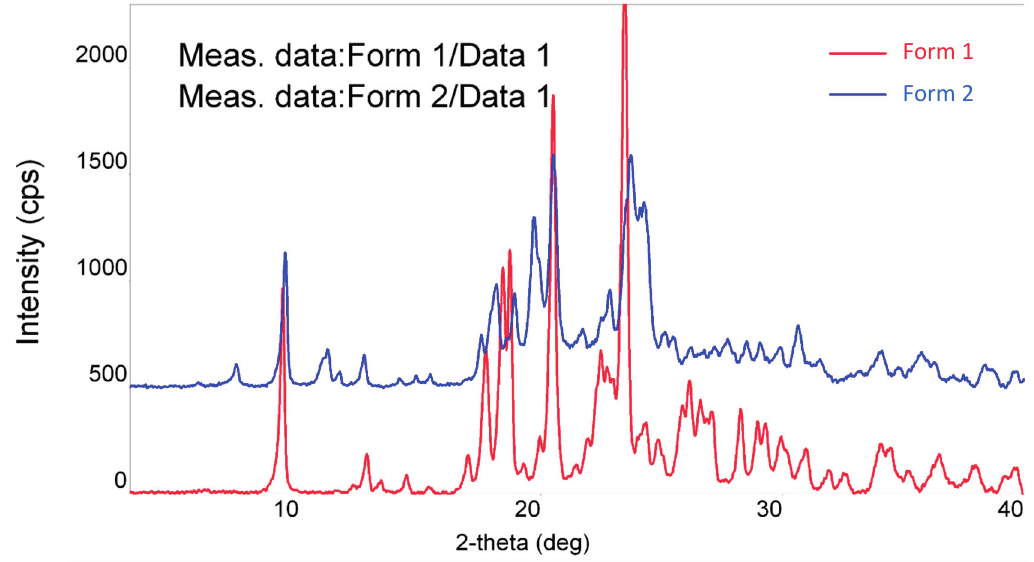
Figure 1. PXRD patterns of pemetrexed diacid forms 1 and 2